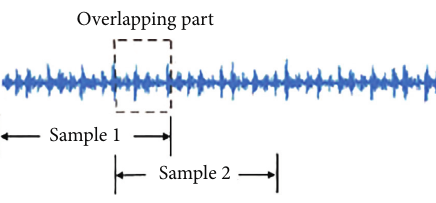
Figure 2: The principle of sample